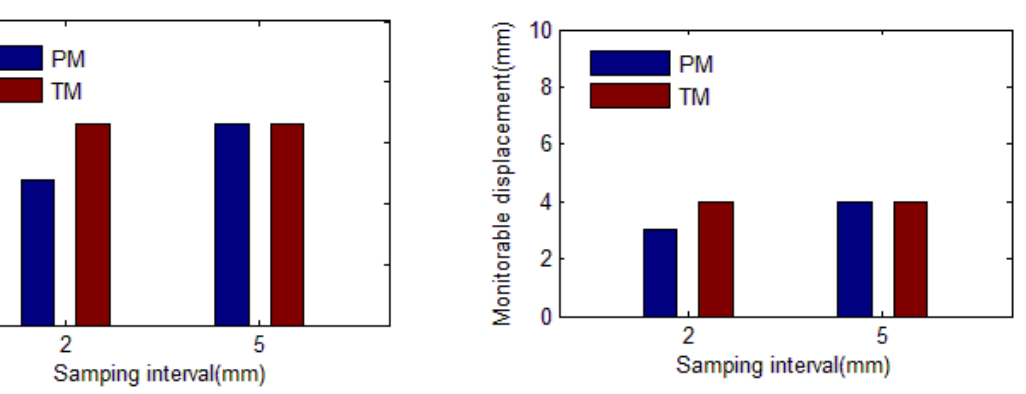
Figure 8. The minimum magnitude of the monitorable